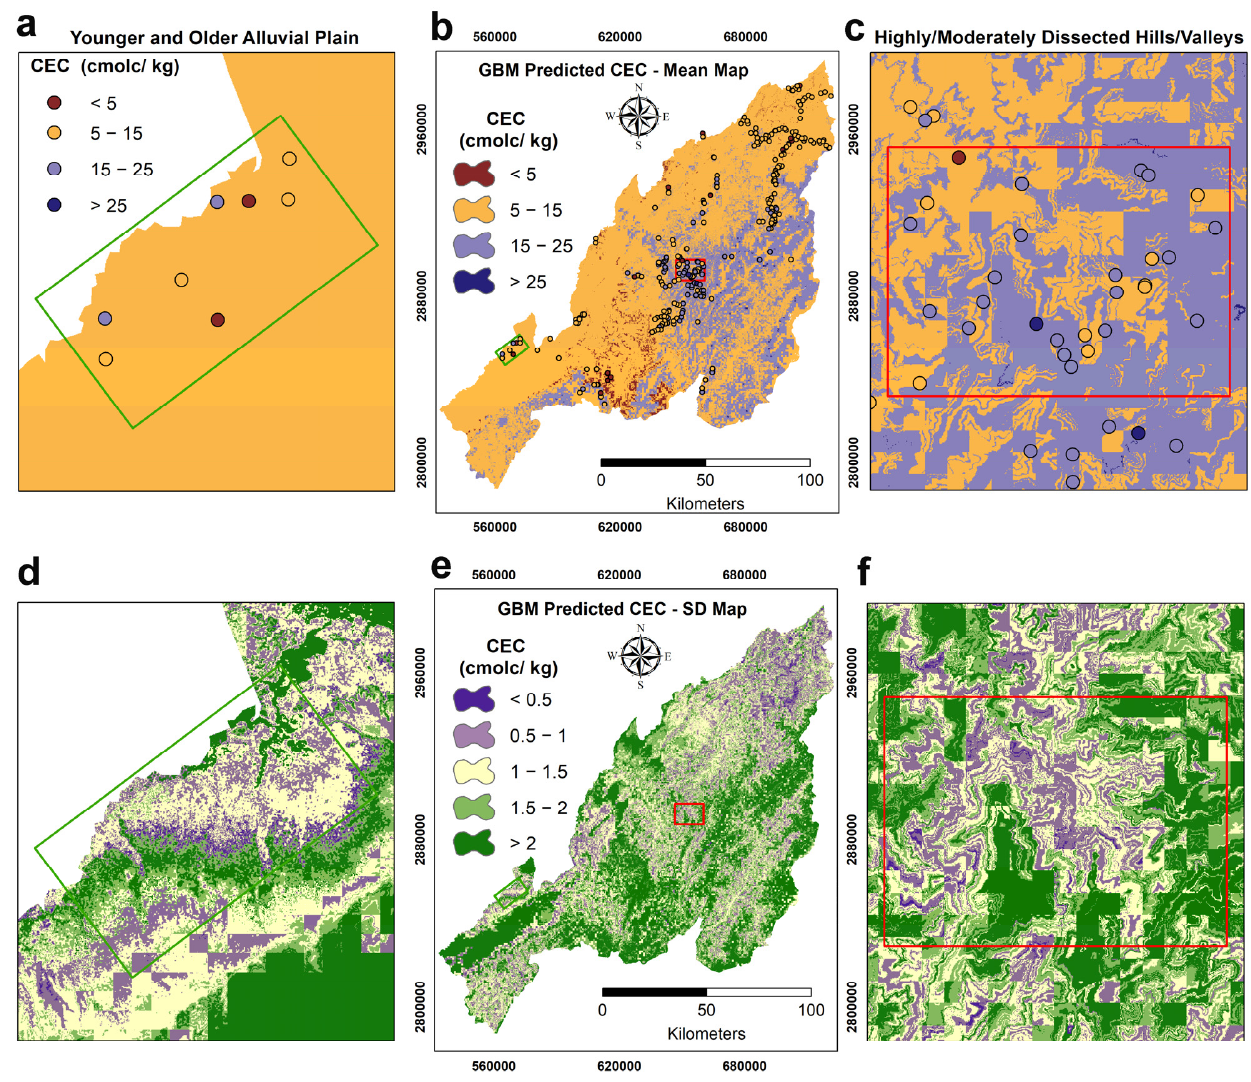
Figure 8. Digital maps of CEC (0–30 cm) were generated by applying a Stochastic Gradient Boosting (GBM) model: Zoomed to a young and older alluvial plain area as mean CEC map ( a ) and as uncertainty CEC map ( d ); mean CEC map over Nagaland ( b ) resulting from the prediction among 10 iterations; zoomed to a highly/moderately dissected hills and valleys as mean CEC map ( c ) and as uncertainty CEC map ( f ); uncertainty CEC map over Nagaland ( e ) resulting from the standard deviation of 10 iterations.